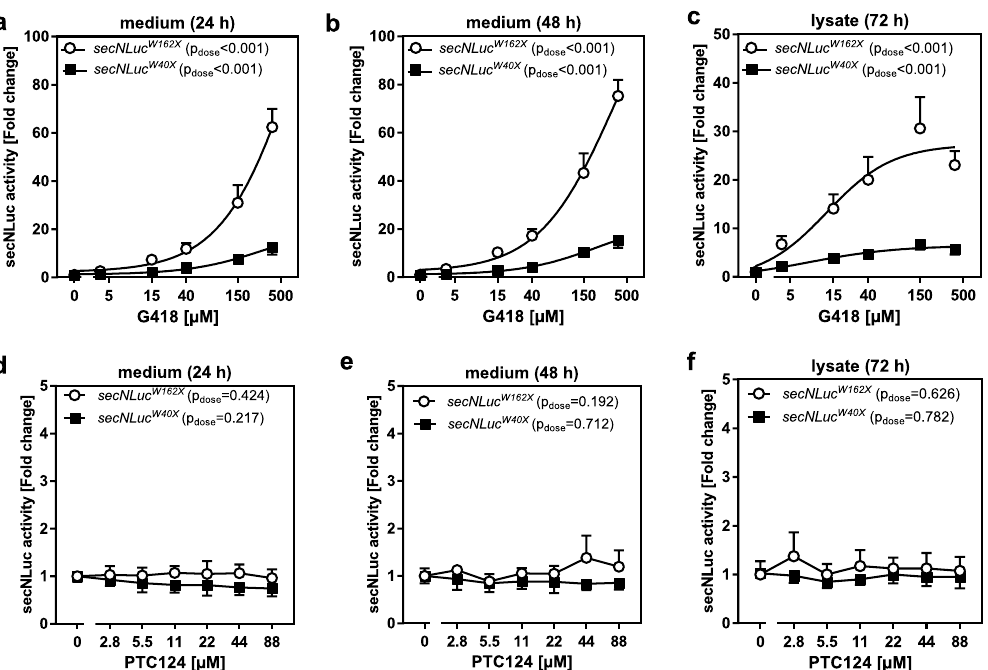
Figure 7. G418 but not PTC124 suppresses nonsense mutations in the secreted NanoLuc luciferase. HEK293 cells were transfected with either the secNLuc W40X and secNLuc W162X overexpression construct. Two days after the transfection, cells were treated for 24 h, 48 h and 72 h with rising concentrations of G418 ( a – c ) or PTC124 ( d – f ) (n = 4, SD). Luciferase activities were measured either in medium or in cell